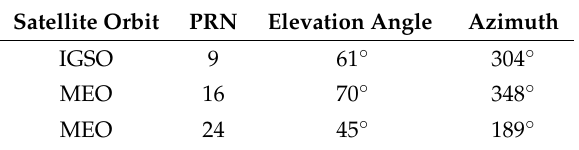
Table 3. Status information of the three acquired BeiDou satellites in the first experiment.